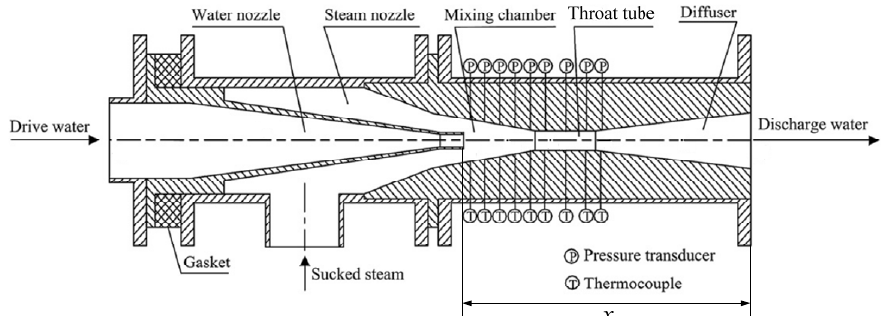
Figure 4. Schematic of the test centered water nozzle steam–water injector.